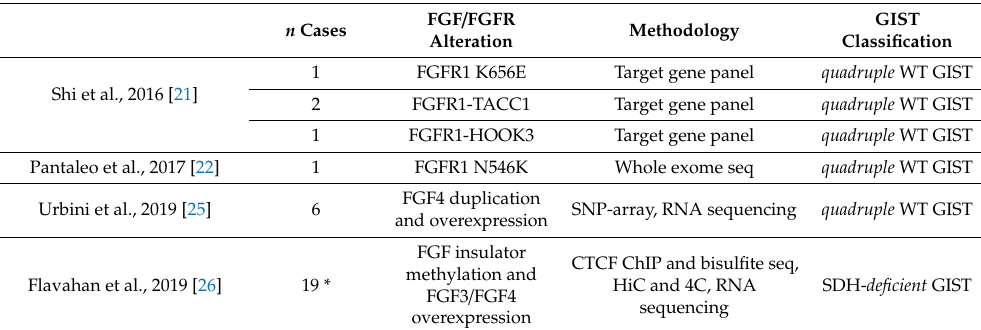
Table 1. FGF / FGFR events in